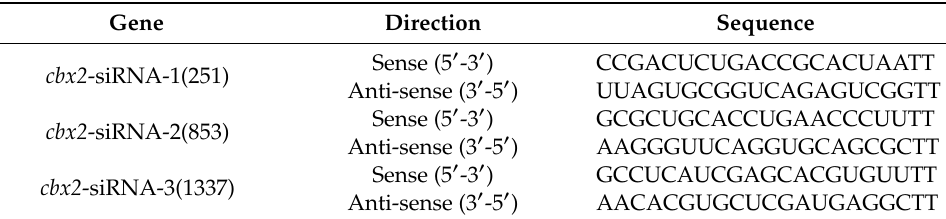
Table 2. siRNA target site and